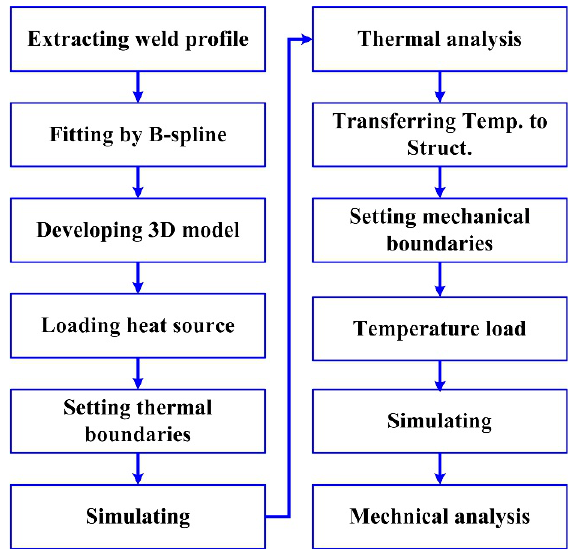
Figure 4. Thermal-elastic-plastic finite element analysis (TEP-FEA) procedure.